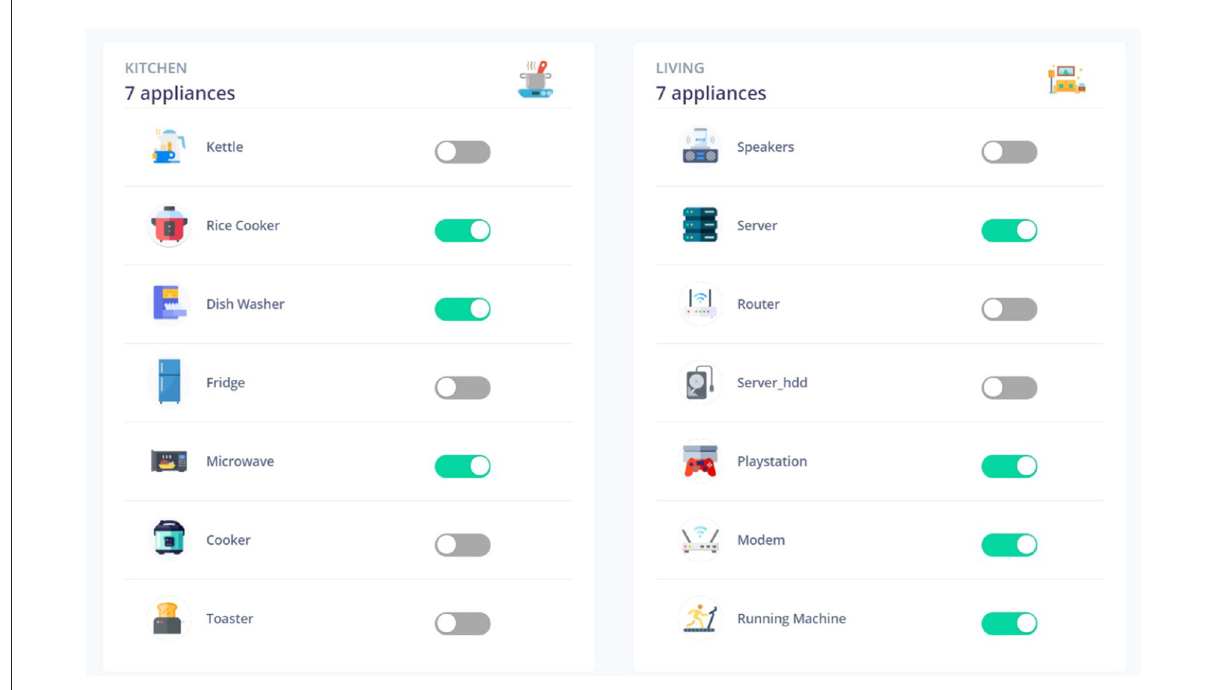
FIGURE8 Appliance control for Kitchen and Living room.